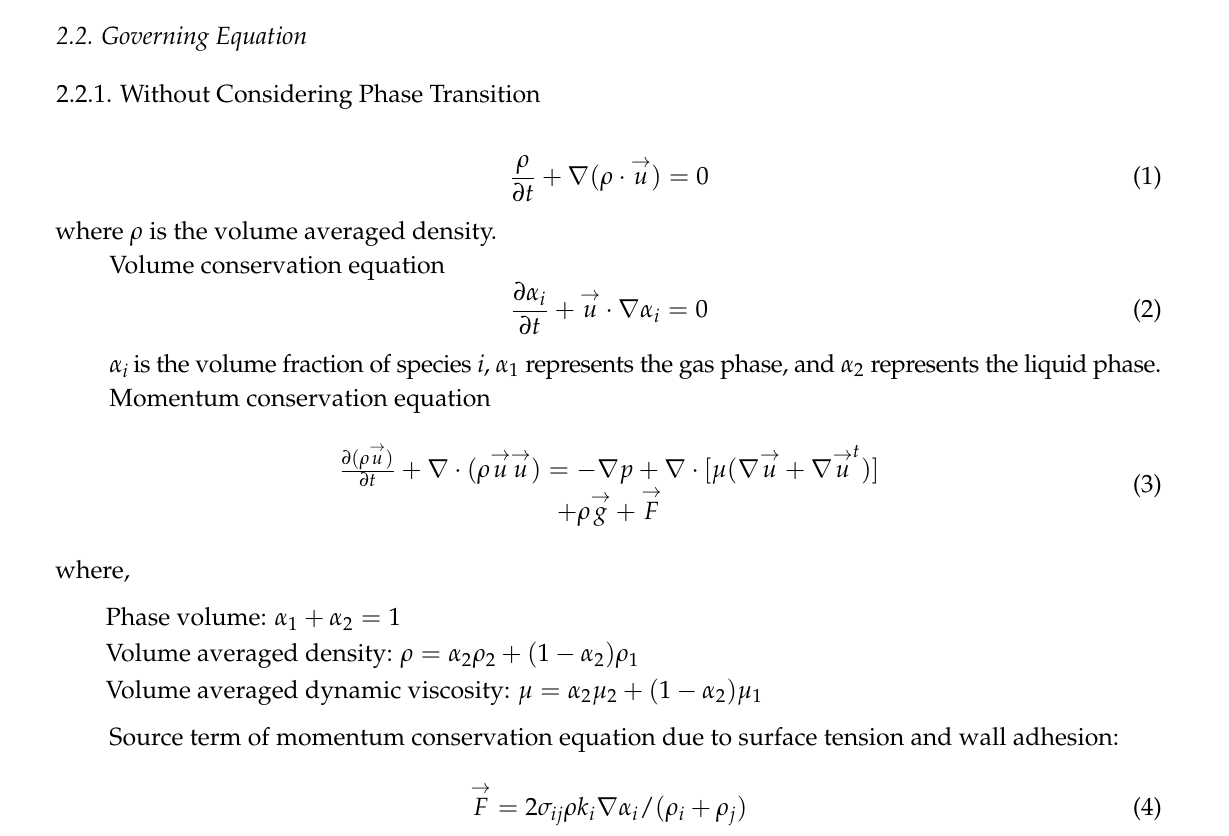
Figure 3. A straight channel with a water inlet hole.